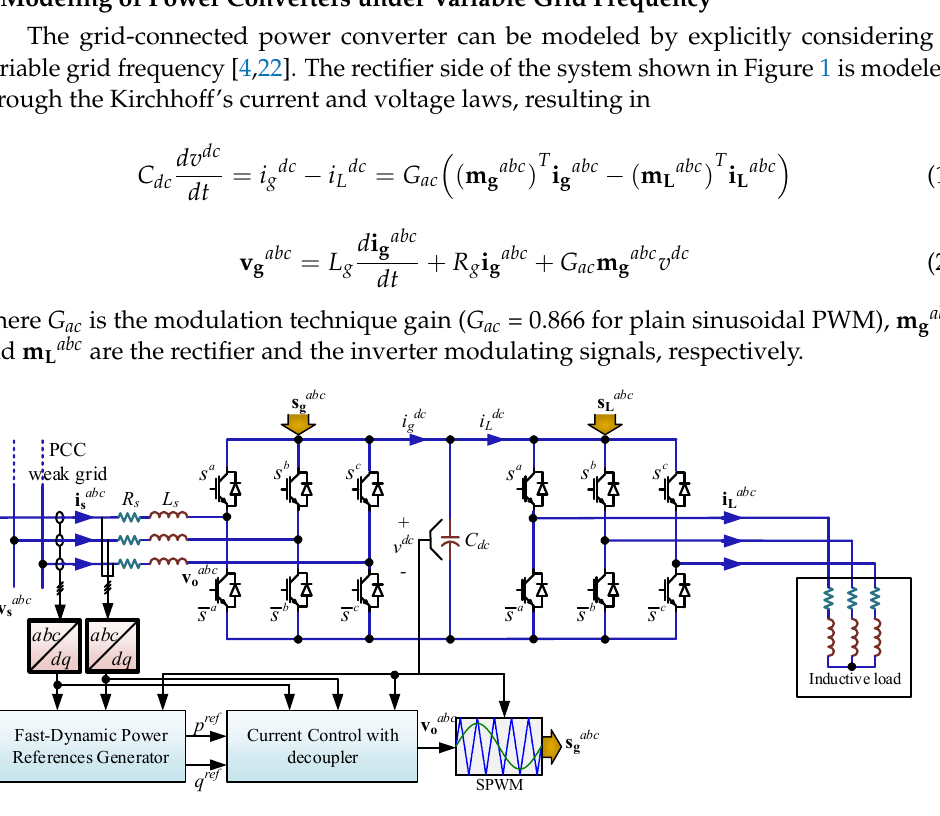
Figure 1. Power Converter System.